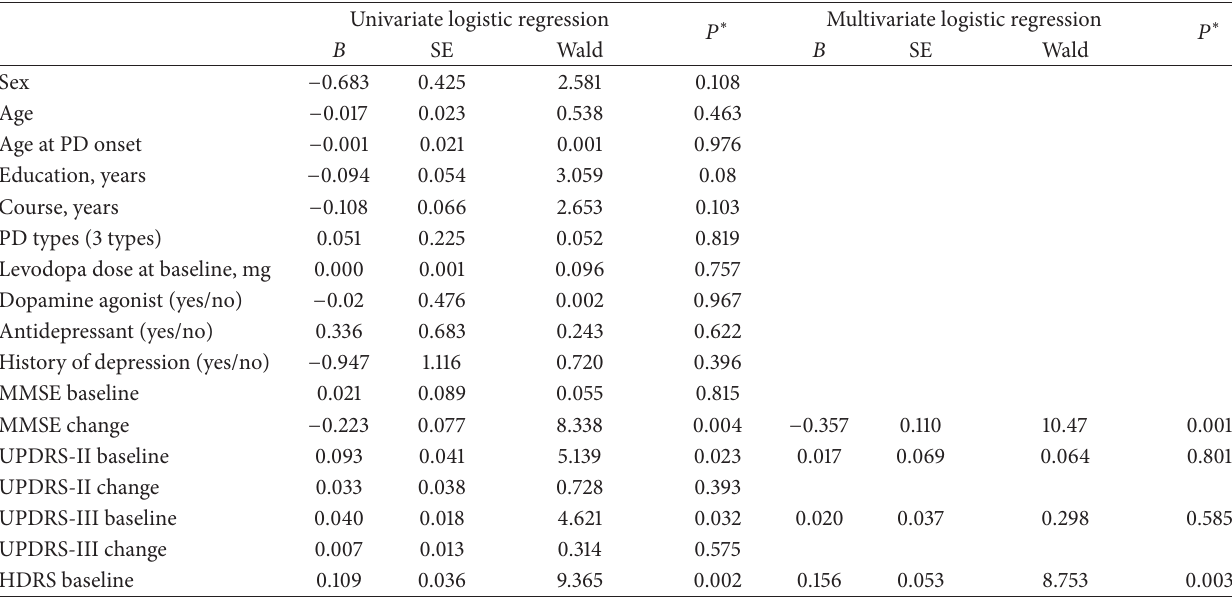
Table 4: Clinical and demographic correlates of having depression after 30-month